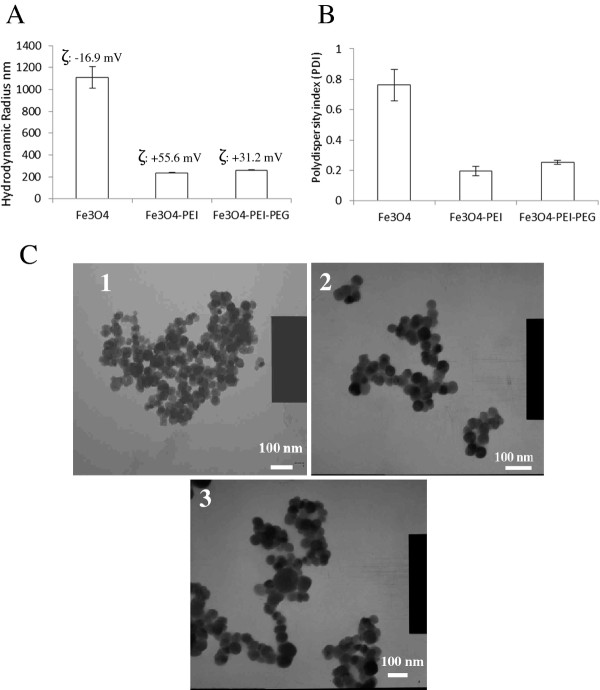
Size estimations of MNPs analysed by A) Photon correlation spectroscopy showing the surface charge and B) Polydispersity index of particles measured at 1 mgmL-1 in deionised water (n = 9 ± SD) and C) TEM images of 1) naked MNP, 2) MNP-PEI and 3) MNP-PEI-PEG.